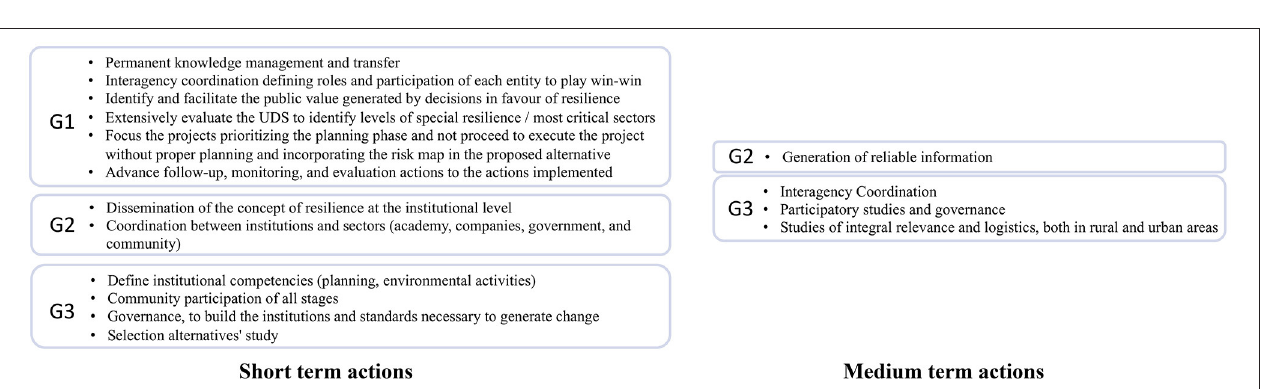
FIGURE 3 | Actions identified to be executed in the short and medium